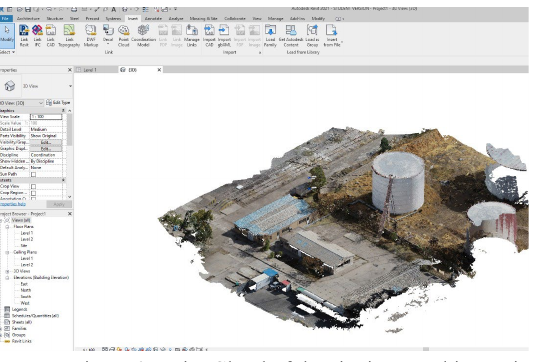
Figure 3. Point Cloud of the site imported in Revit The point cloud file provides an accurate geometrical basis for the modeling process, indicating the location of various building and their elements on the site. Using the conventional modeling tools in Revit, it is possible to build up the model with precise geometrical data provided by the point cloud. In order to enrich the model with data for further purposes such as its employment on Digital Twin platforms, the building elements such as walls and roofs were defined with accurate data related to their materials and